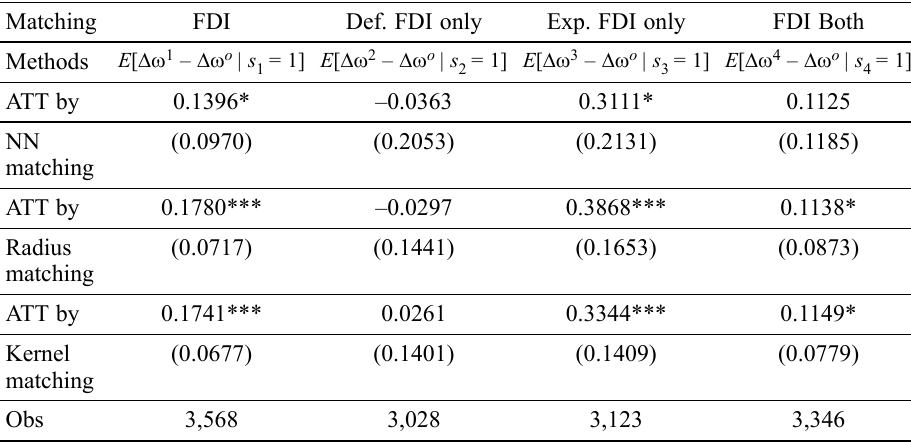
Table 4. Estimation of average treatment effect on the treated (outcome variable: rate of productivity growth)